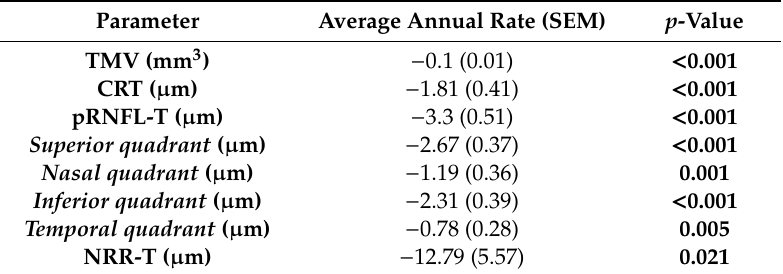
Table 3. Longitudinal analysis of the OCT parameters in RR-MS patients.